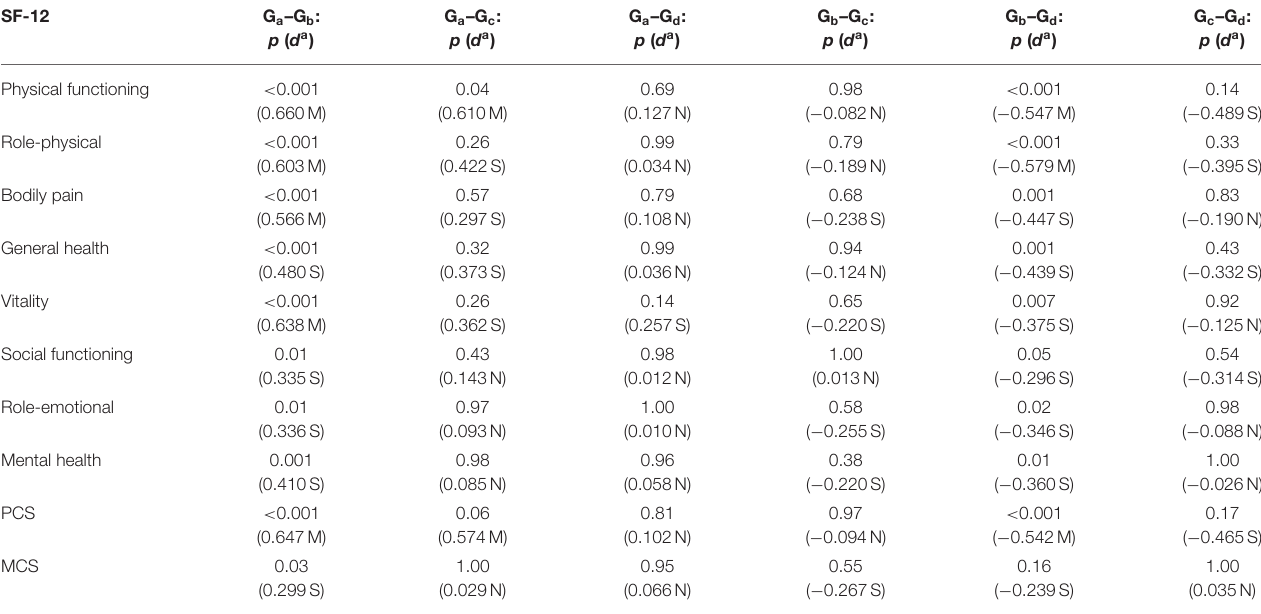
TABLE 6 | Comparison of quality of life (SF-12) in non-alcoholic fatty liver disease (NAFLD) severity groups: non-alcoholic steatohepatitis (NASH; with and without significant fibrosis) and no-NASH (with and without significant fibrosis). SF-12